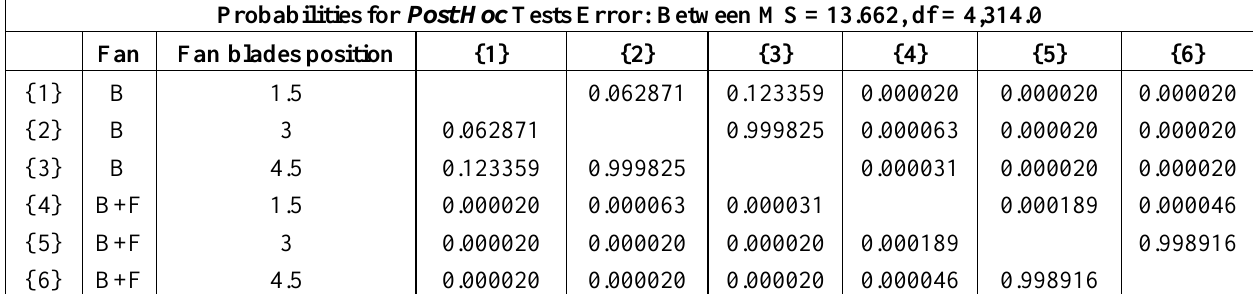
Table 3. Tukey HSD test; dependent variable: air velocity (m/s). Independent